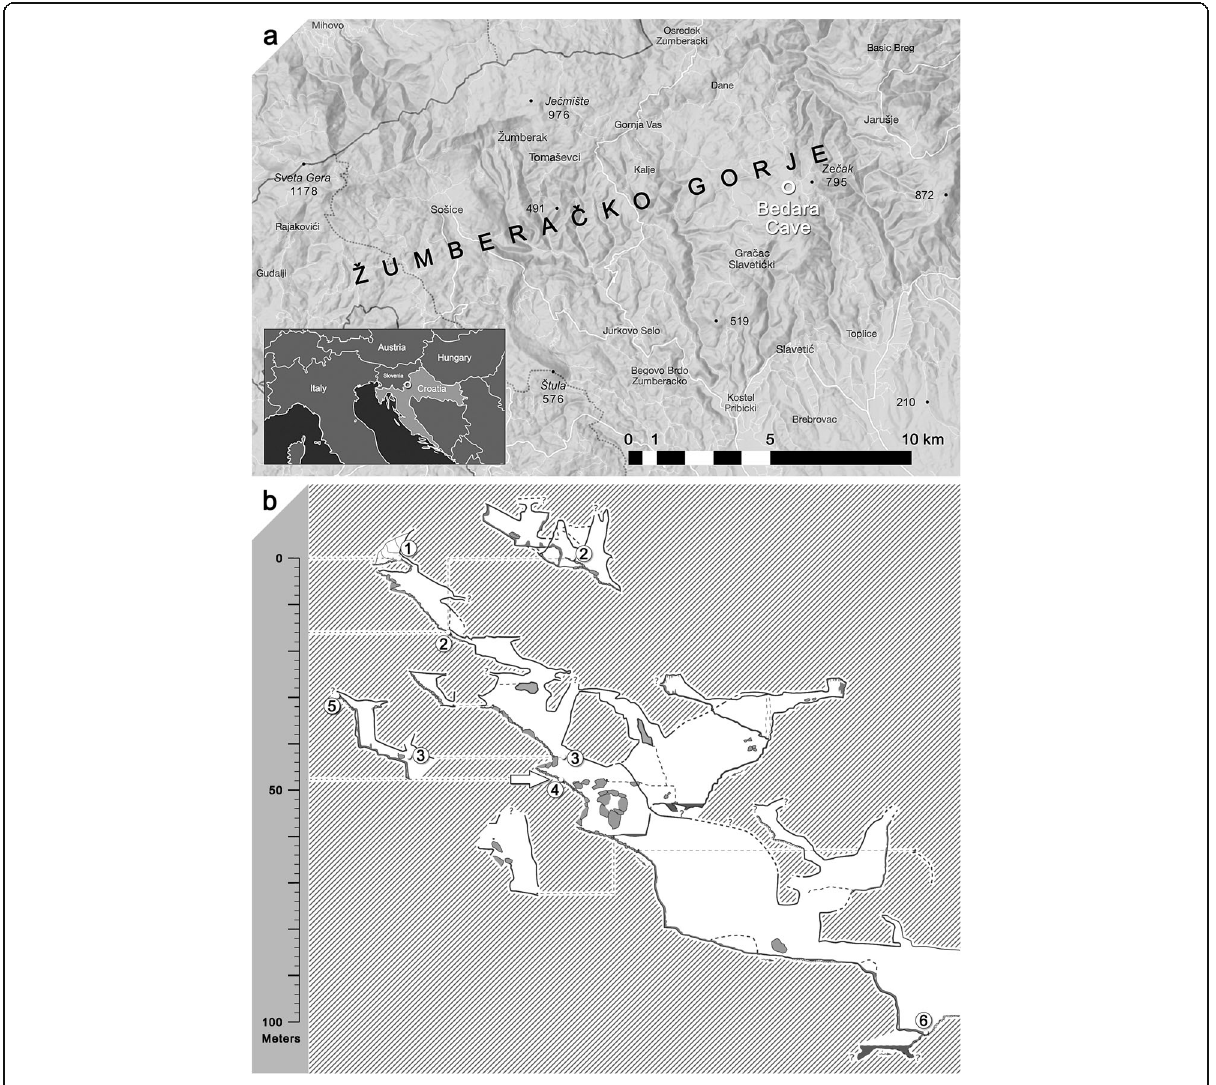
Fig. 1 a Map of the Ž umbera č ko Gorje region in northwestern Croatia. The Bedara cave is located on Mt. Ž umbera č ka Gora. The area lies at the transition between the southeastern Alps, the northwestern Dinarides and the Pannonian Basin. Altitudes range from 180 to 1,178 m above sea level, with Sveta Gera (1,178 m above sea level) as the highest peak. b Schematic representation of the Bedara cave. From the entrance (1) measuring 0.4 × 0.8 m to the location of the find, the passages are of mostly knee-shaped and pit-like morphology. The current entrance and passage are located at a depth of 16 m (2). The cave features several vertical passages without connection to the surface, such as the one at the discovery site, at a depth of 47 m (4), where also a constant flow of drip water exists (5). Further skeletal remains may have been washed away into the deeper parts of the cave